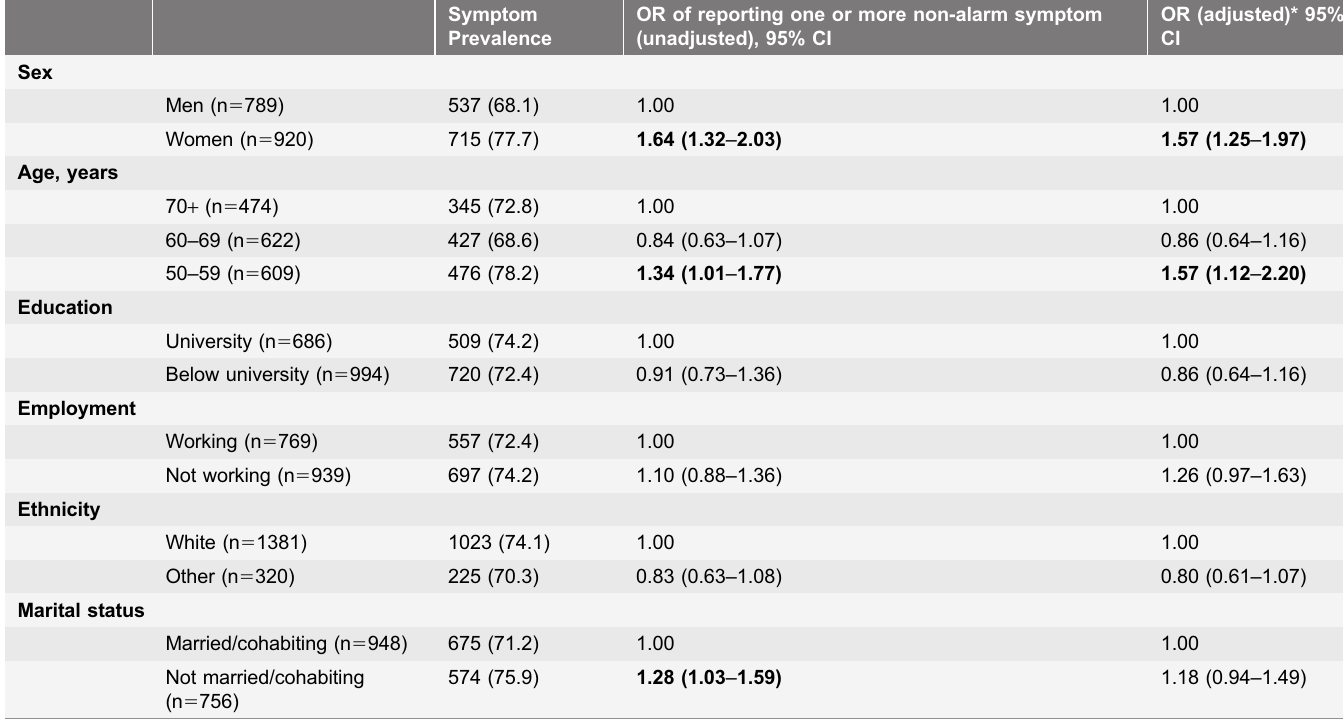
Table 5. Prevalence, unadjusted and adjusted odds ratios of reporting one or more non-alarm